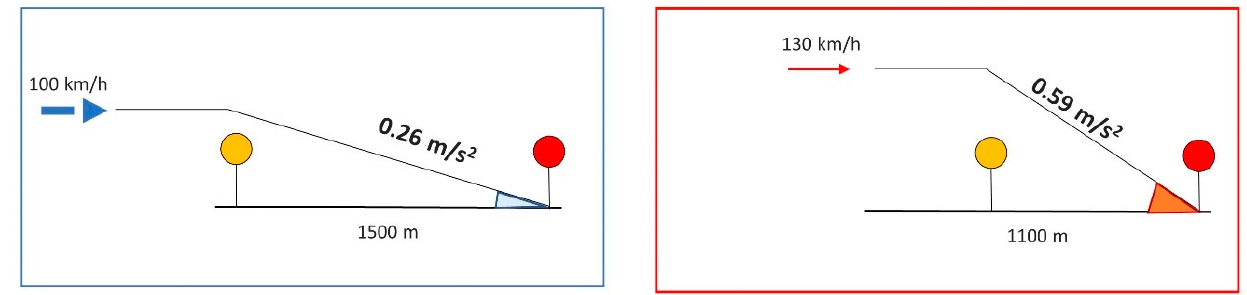
Figure 10. During the deviating approach (right), a greater deceleration rate is required than during the standard approach (left). During both approaches, the cue is the same (yellow) but the location is different. The two mean deceleration values (values in bold) are examples. In reality, the mean deceleration value can be any value below the track speed-dependent maximums.